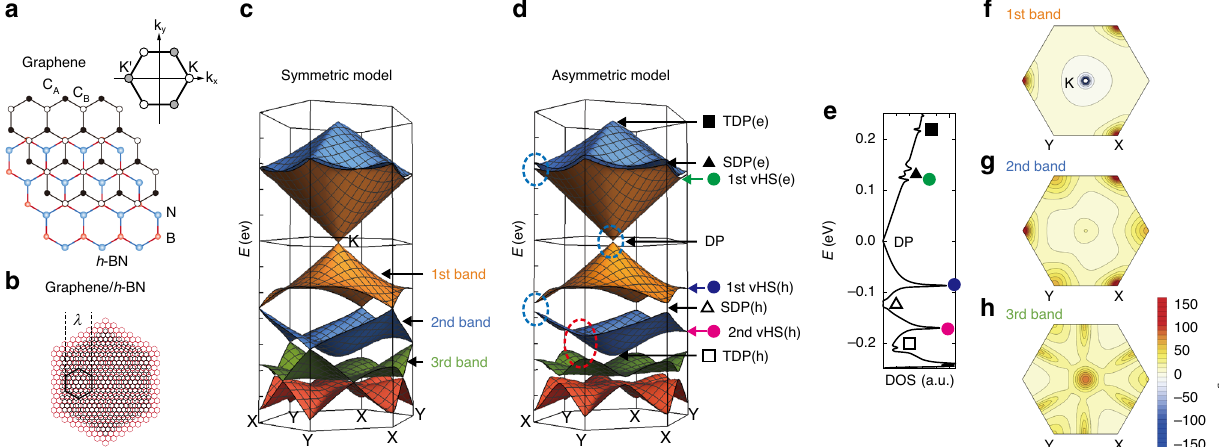
Fig. 1 Orbital magnetic moment in graphene/ h -BN moiré superlattice. a Crystal structure of graphene and h -BN. The inset depicts the corresponding k- space of the Fermi surface of graphene. b Moiré pattern generated in the aligned graphene/ h -BN heterostructure. The period of moiré potential λ is indicated. Here, the lattice constant of h -BN is drawn 20% larger than that of graphene to enhance the visibility of the moiré pattern. c , d Band structure of the graphene/ h -BN moiré superlattice with θ = 0° at the K-point calculated using an effective continuum model. Calculation is performed under an c inversion symmetric model and an d inversion asymmetric model. The band structure exhibits series of bands — the fi rst, second, and third bands — located at the hole-side of the DP. In addition to the main DP, series of secondary (SDPs) and tertiary DPs (TDPs) are observed in the electron- (e) and hole- (h) sides of the main DP; these are indicated by solid black square (electron-side TDP), solid black triangle (electron-side SDP), open black triangle (hole-side SDP), and open black square (hole-side TDP), respectively. In addition, series of vHS points are observed in between the DPs; these are indicated by solid green circle (electron-side fi rst vHS), solid blue circle (hole-side fi rst vHS), and solid magenta circle (hole-side second vHS), respectively. e Relationship between energy E and density of states (DOS) of aligned graphene/ h -BN derived from band structure in d . f – h Calculated orbital angular moment m ( k ) for hole-side f fi rst band, g second band, and h third